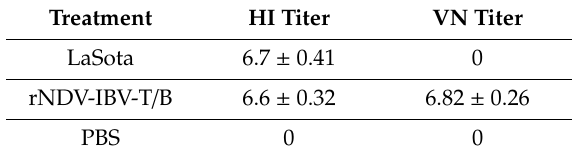
Table 2. Serum NDV- and IBV-specific antibody response of chickens post-immunization. Treatment